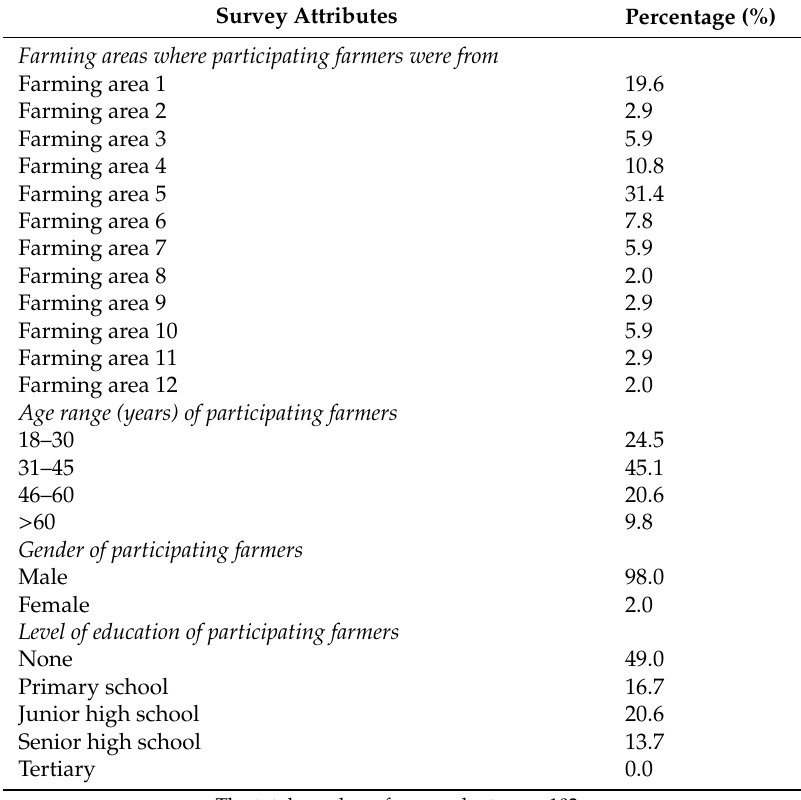
Table 1. Demography of surveyed vegetable farmers in Accra,